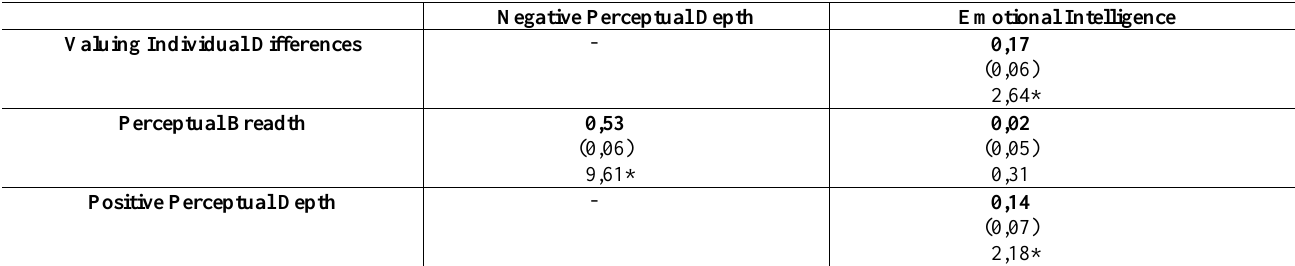
Table 6: Unstandardized gamma (  ) matrix Negative Perceptual Depth Emotional Intelligence Valuing Individual Differences - 0,17 Perceptual Breadth Positive Perceptual Depth